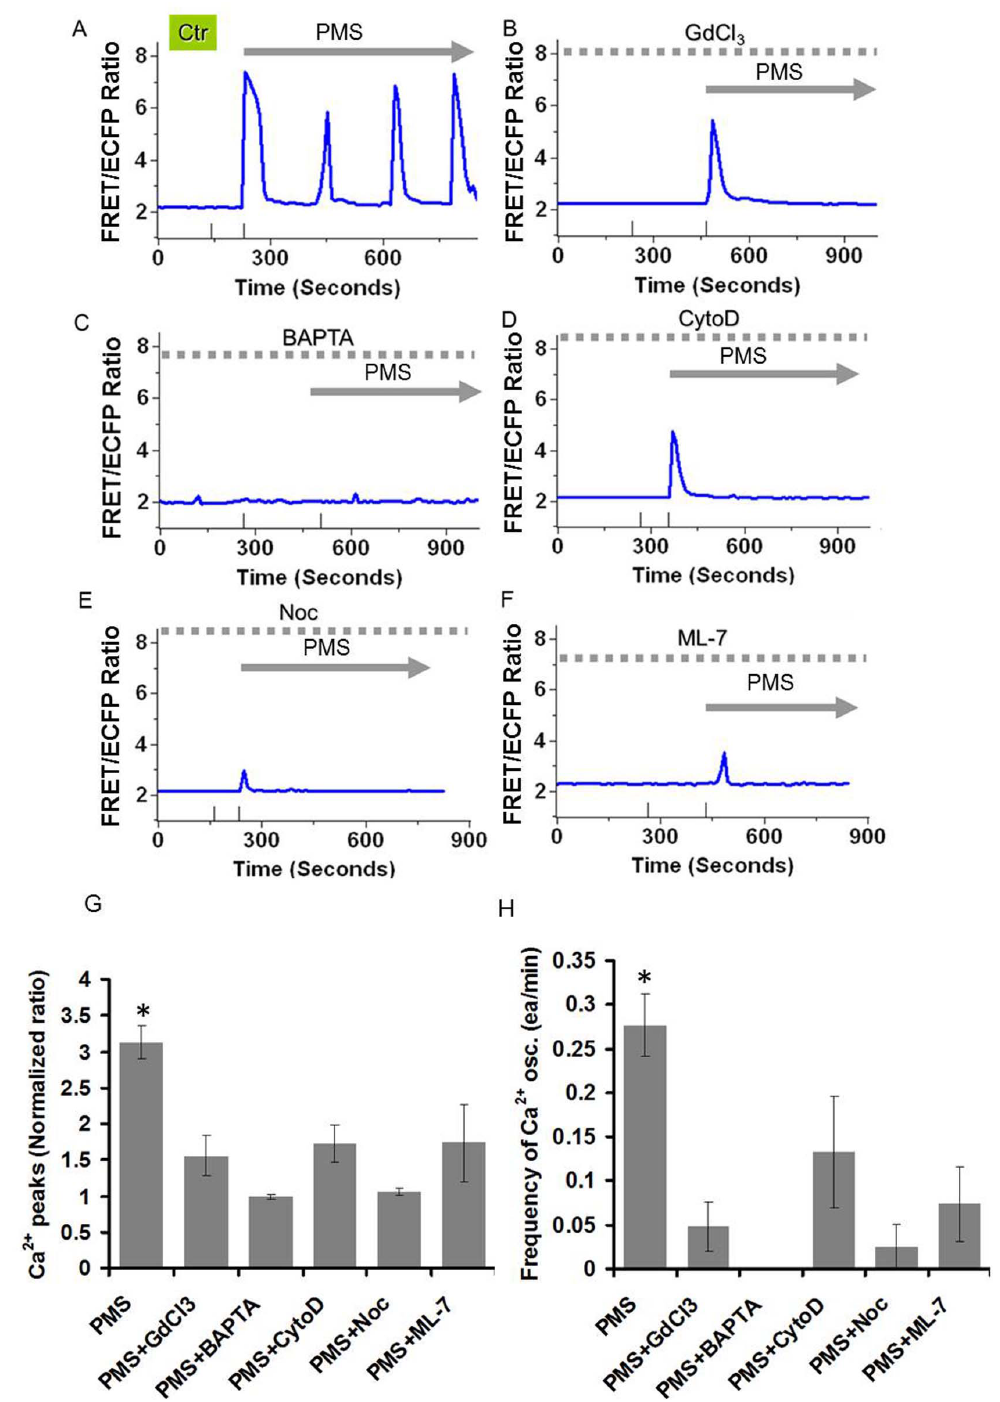
Figure 3. Calcium oscillations triggered by the PMS depend on calcium entry via the plasma membrane, cytoskeleton and actomyosin contractility. (A) PMS evokes calcium oscillations in a subpopulation of hMSCs without spontaneous activities (Ctr; control). (B, C) PMS-induced calcium oscillations were inhibited in GdCl 3 - or BAPTA-pretreated cells, suggesting the involvement of calcium entry at the plasma membrane. (D, E, F) PMS-induced calcium oscillations were also inhibited in CytoD-, Noc-, or ML-7 pretreated cells, suggesting the involvement of cytoskeleton and actomyosin contractility in the PMS-induced calcium oscillations. Amplitude (G) and frequency (H) of PMS-induced calcium oscillations are inhibited in the presence of inhibitors. PMS, control group with prolonged mechanical stretch only (n=9); PMS + GdCl 3 (5 m M), an inhibitor of stretch-activated calcium channel was applied 1 hr before stretch (n=4); PMS + BAPTA (20 m M in the calcium free medium), a calcium chelator was applied before stretch (n=5); PMS + CytoD (1 m M), an inhibitor of actin filament was applied 1 hr before stretch (n=5); PMS + Noc (5 m M), an inhibitor of microtubule was applied 1 hr before stretch (n=4); PMS + ML-7 (10 m M), an inhibitor of MLCK was applied 1 hr before stretch (n=4). * indicates statistically significant difference from all other groups by the Bonferroni multiple comparison test with p , 0.05.